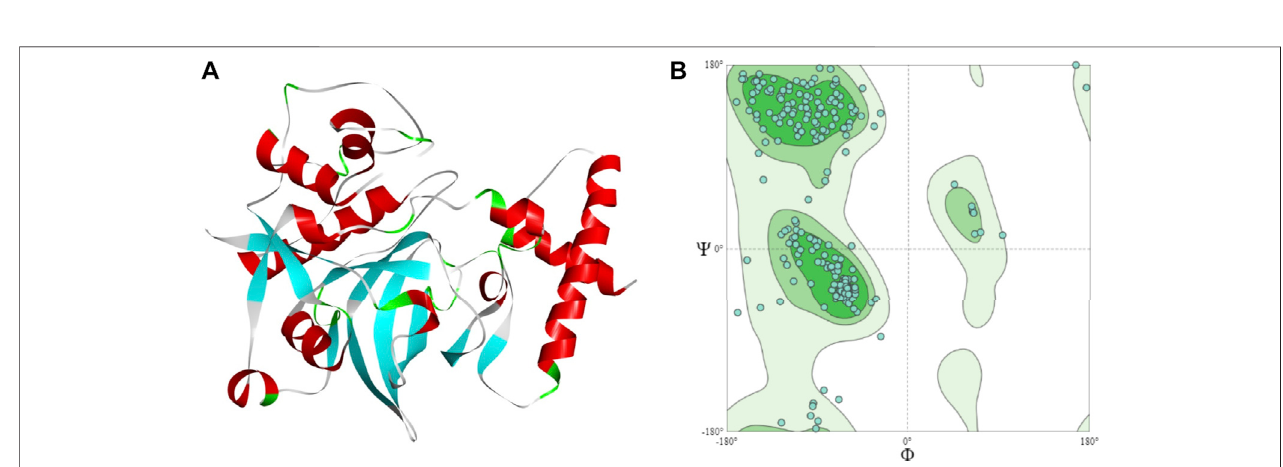
Frontiers in Pharmacology |